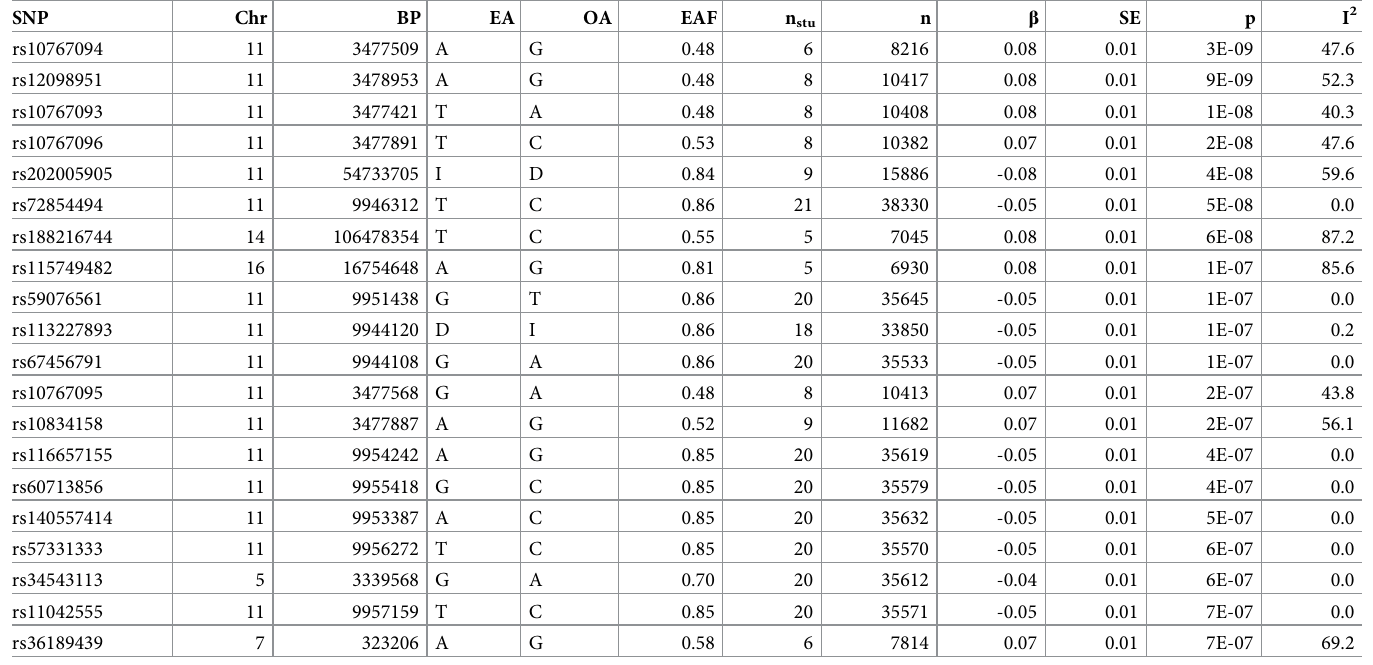
Table 2. SNPs with genome-wide significant (p < 5E-08) and suggestive (p < 5E-07)